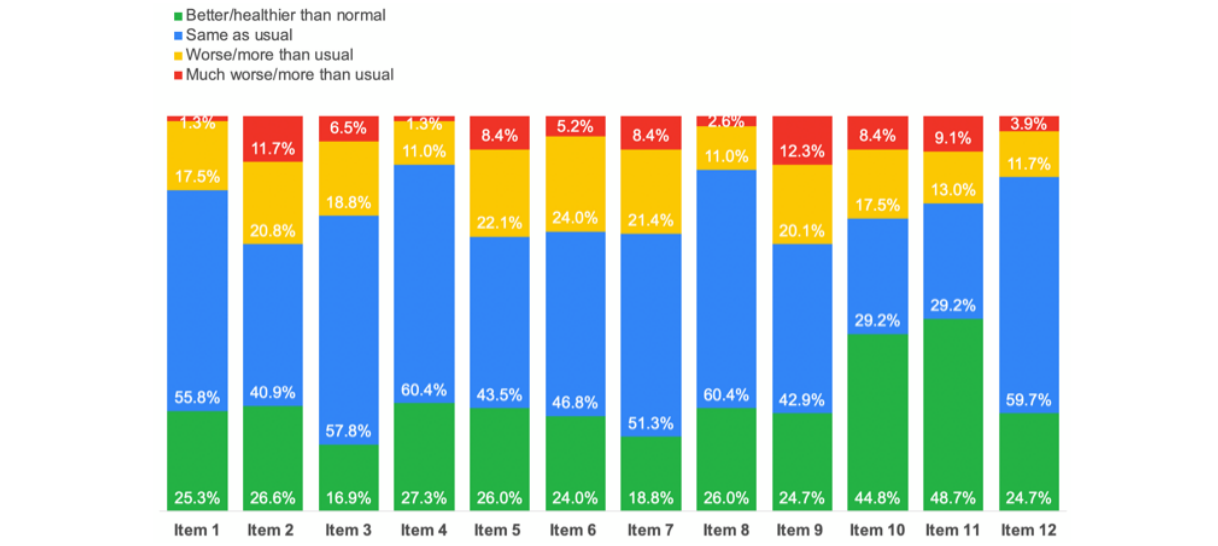
Figure 1. Proportions of participants’answers to the 12-item General Health Questionnaire.